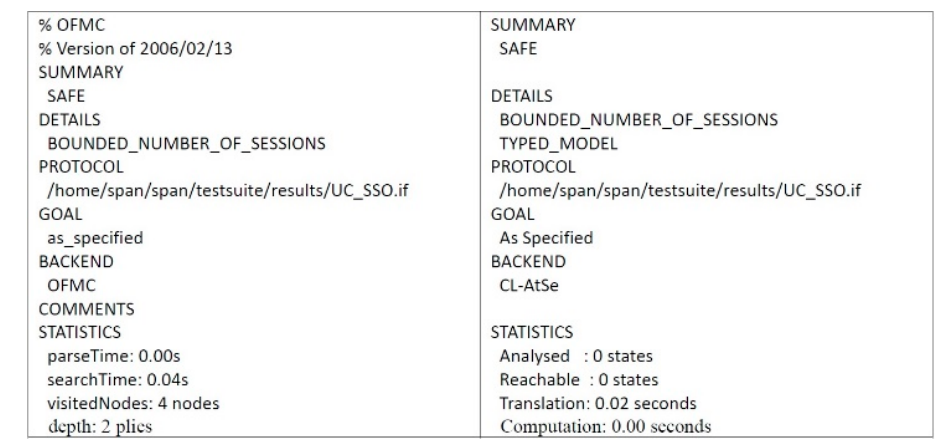
Figure 8. HLPSL specification of session role, environment role, and goals.